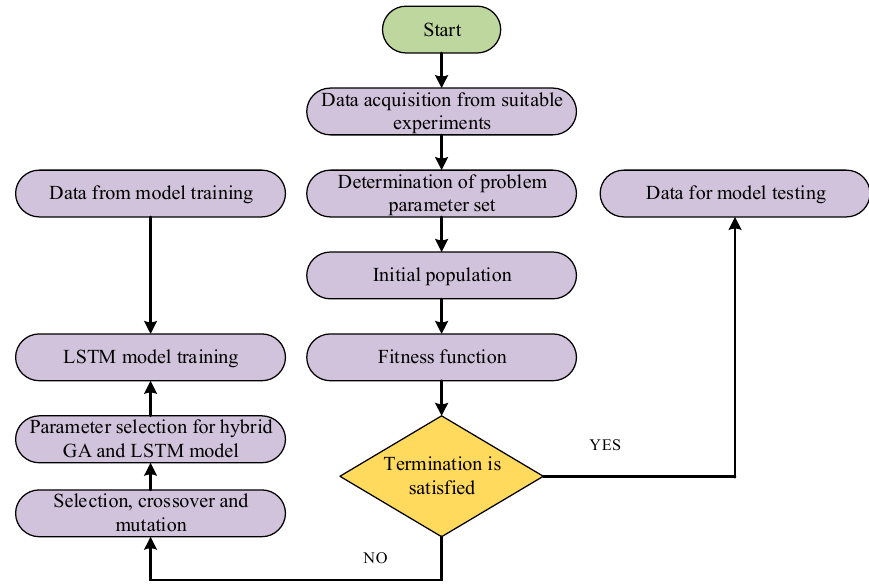
Figure 9. Hybrid GA and LSTM model for RUL prediction of supercapacitor.